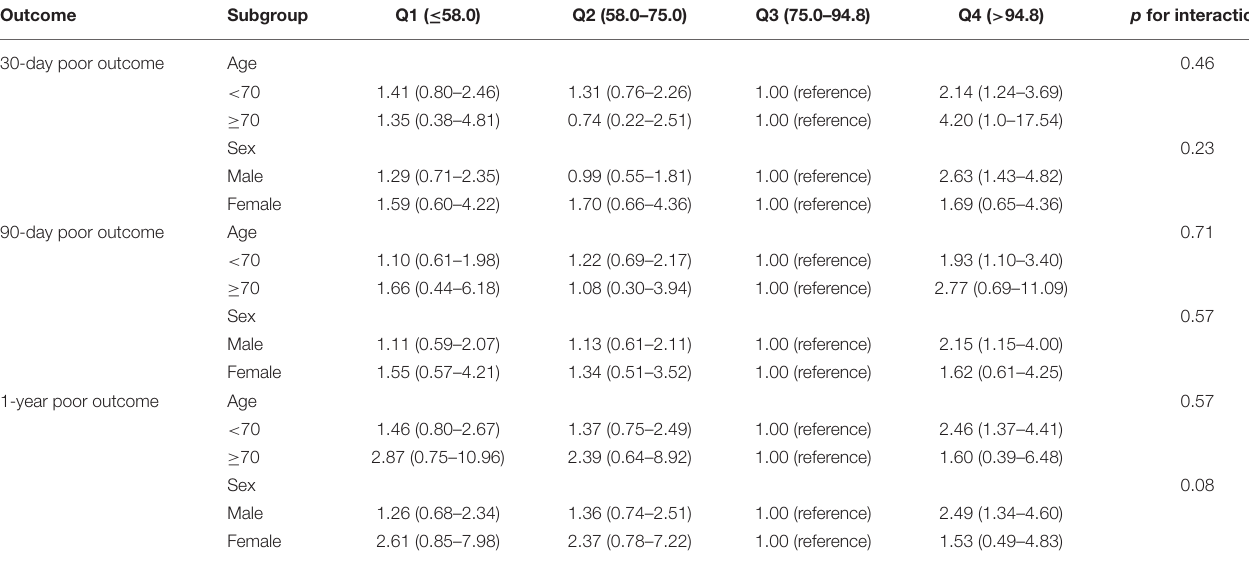
TABLE 3 | Multivariate-adjusted OR and 95% CI for poor outcome according to quartiles of ALP levels, stratified by age and sex.